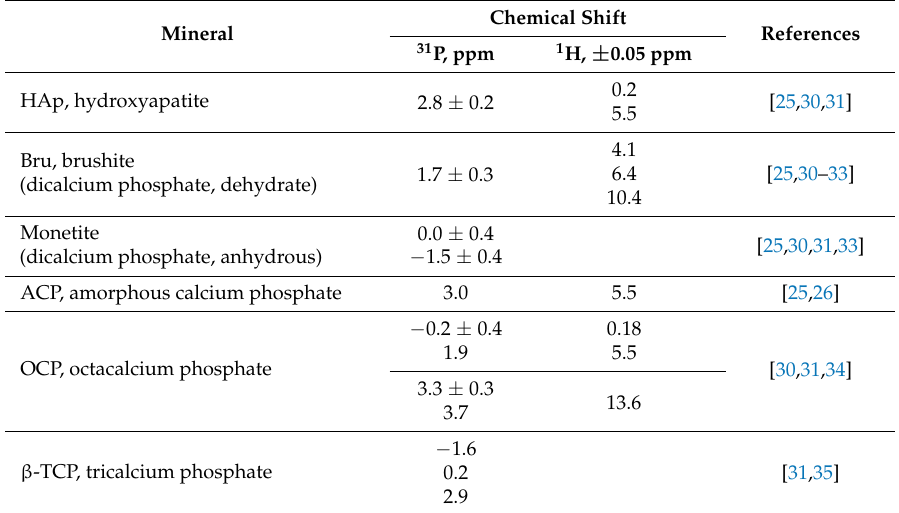
Table 1. 31 P and 1 H chemical shift parameters for calcium phosphate structures reported in the literature.